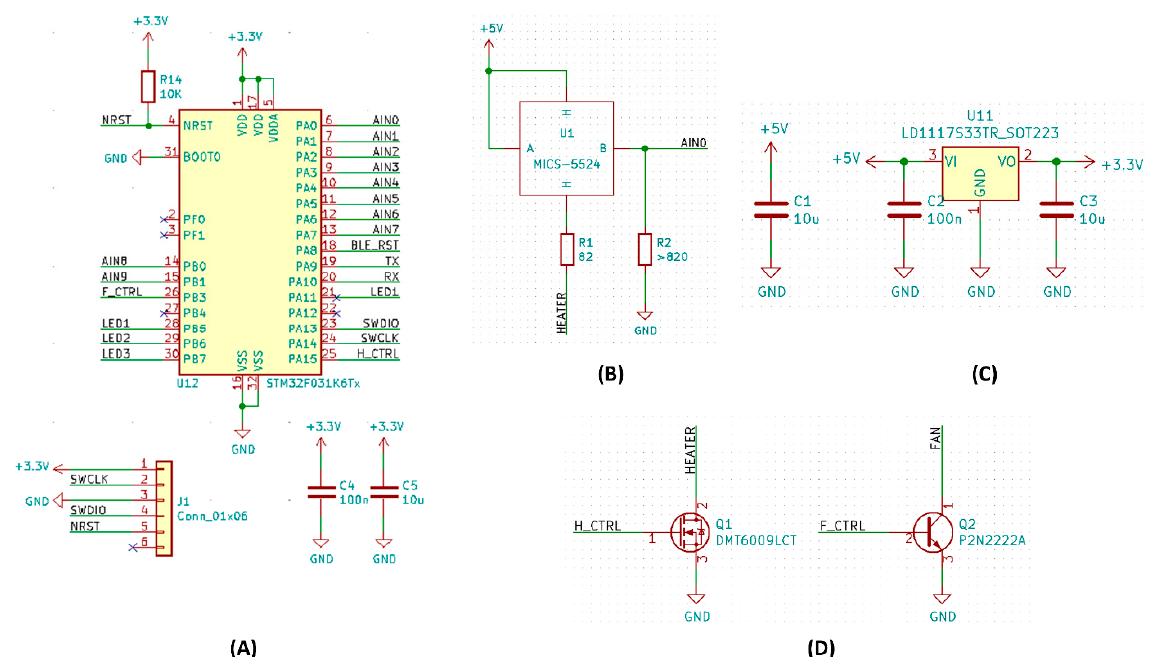
Figure 3. Circuit diagram of the proposed system. ( A ) STM32 microcontroller was used to control and collect all the data. ( B ) Each sensor is powered by a 5 V signal and enable pin, while a potentiometer (R2) is used to provide a voltage divider circuit. Shown here is the MICS-5524 sensor, which, unlike other sensors, requires a heater to operate. ( C ) The voltage regulator part is responsible for charging the battery. ( D ) The proportional control of heater and fan via transistors.